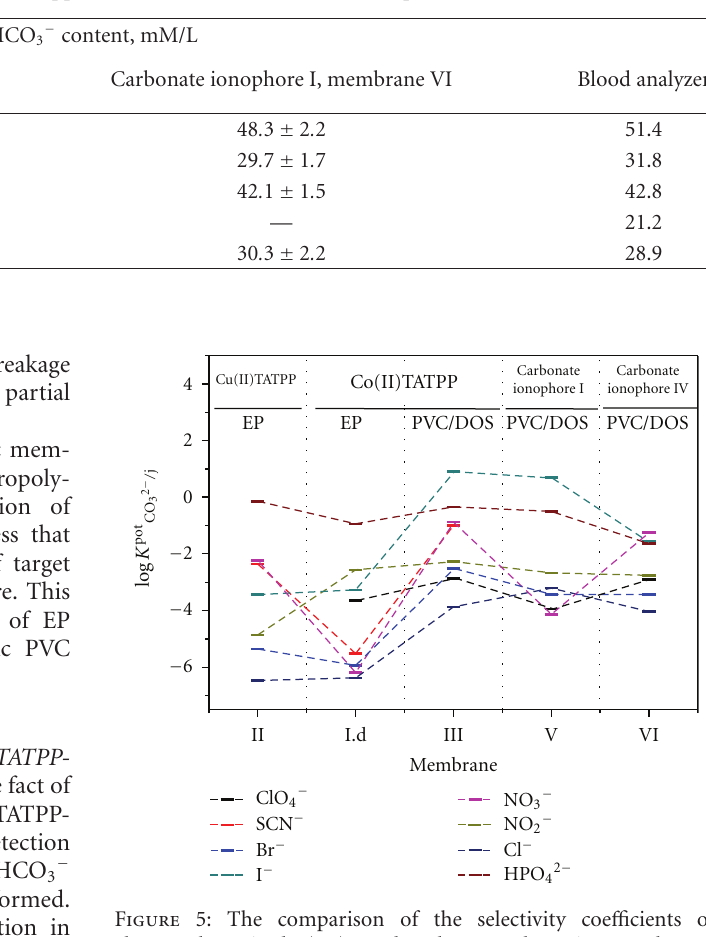
Table 2: Results of developed sensors application for bicarbonate detection in plasma ∗ .